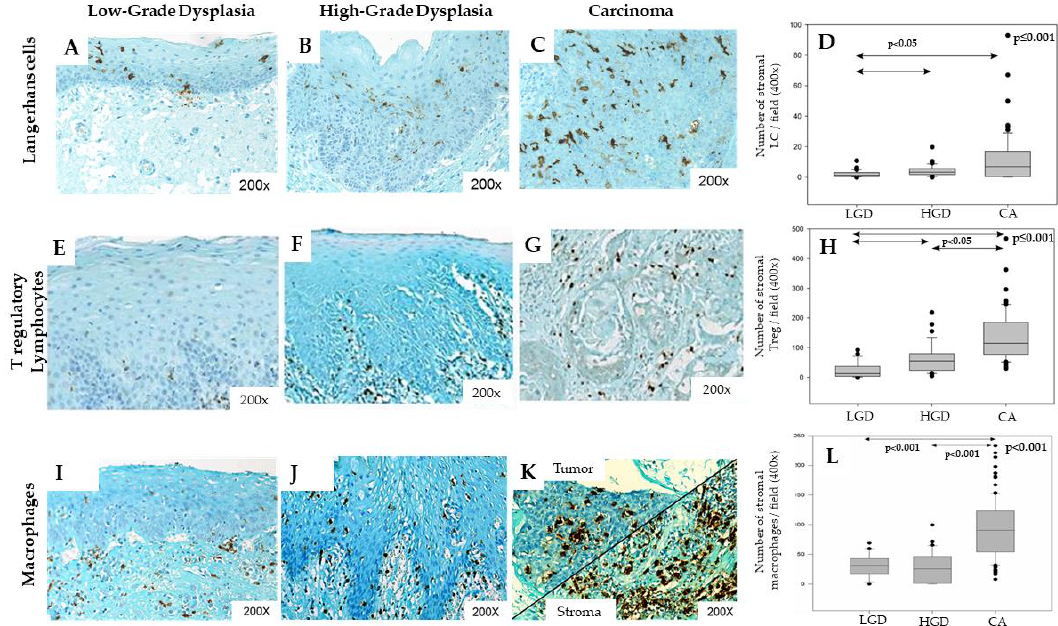
Figure 3. Langerhans cells, Treg lymphocytes and macrophages infiltration increases during HNSCC progression. Immunohistochemical representation of CD1a + Langerhans cells, FoxP3 + Treg and CD68 + macrophages in Low-Grade Dysplasia (LGD) ( A , E , I ), High-Grade Dysplasia ( B , F , J ), and carcinoma (CA) ( C , G , K ) from head and neck patients. Kruskall–Wallis tests illustrating the increasing number of Langerhans cells ( D , p ≤ 0.001), Treg lymphocytes ( H , p ≤ 0.001) and macrophages ( L , p < 0.001) in the stromal compartment during tumor progression.